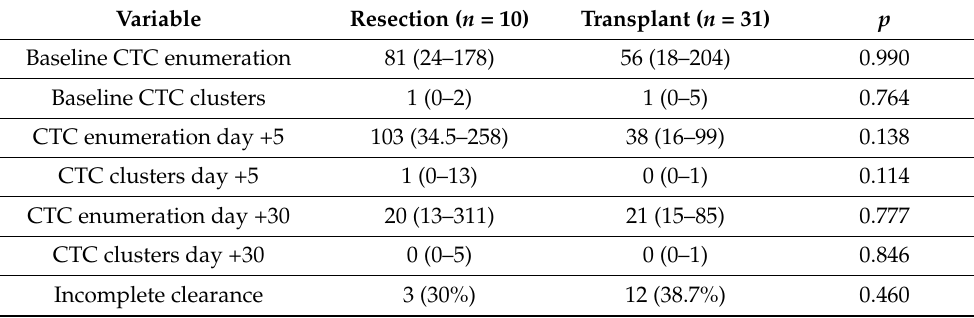
Table 3. Relative delta changes of CTCs enumeration and clusters from baseline to post-operative day 30 according to clinical features.